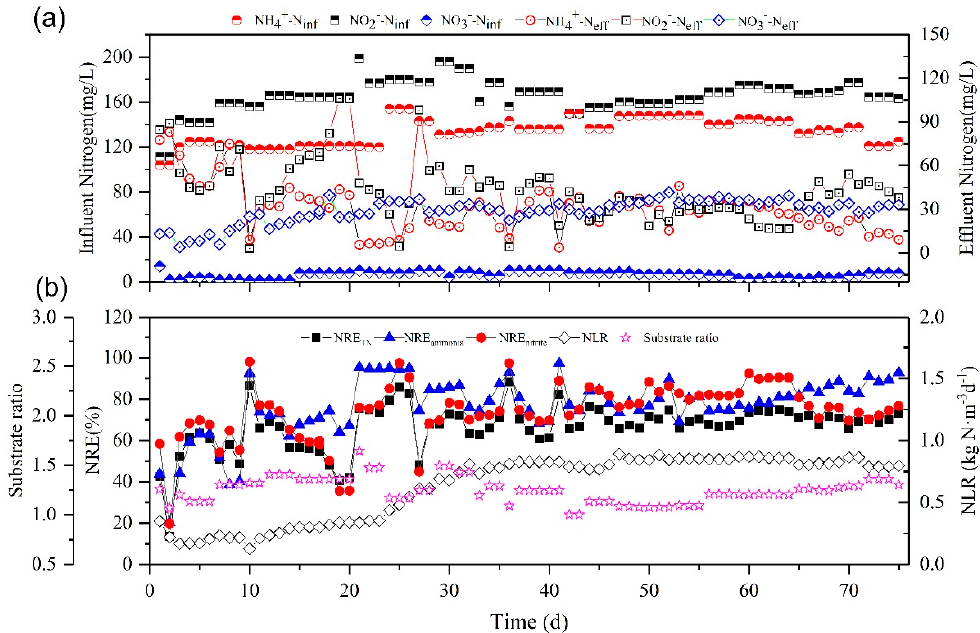
Figure 5. Performance of up-flow blanket filter and the influence of substrate ratio on anammox: ( a ) influent and effluent nitrogen variations, ( b ) variations of nitrogen removal performance and substrate ratio in anammox reactor.